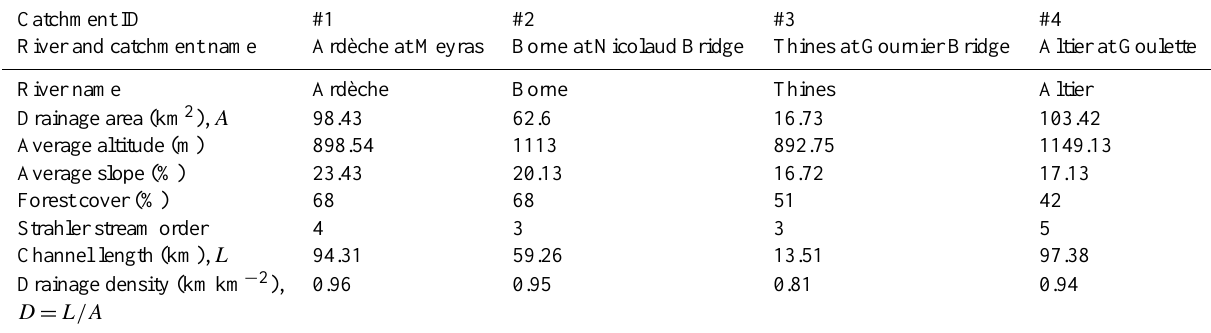
Table 1. Physiographic characteristics of the four examined Ardèche sub-catchments. Strahler stream order, channel length and drainage density are calculated from the 25m IGN DTM using TauDEM tools (Tarboton et al., 2009). Catchment ID #1 #2 #3 #4 River and catchment name Ardèche at Meyras Borne at Nicolaud Bridge Thines at Gournier Bridge Altier at Goulette River name Ardèche Borne Thines Altier Drainage area (km 2 ), A 98.43